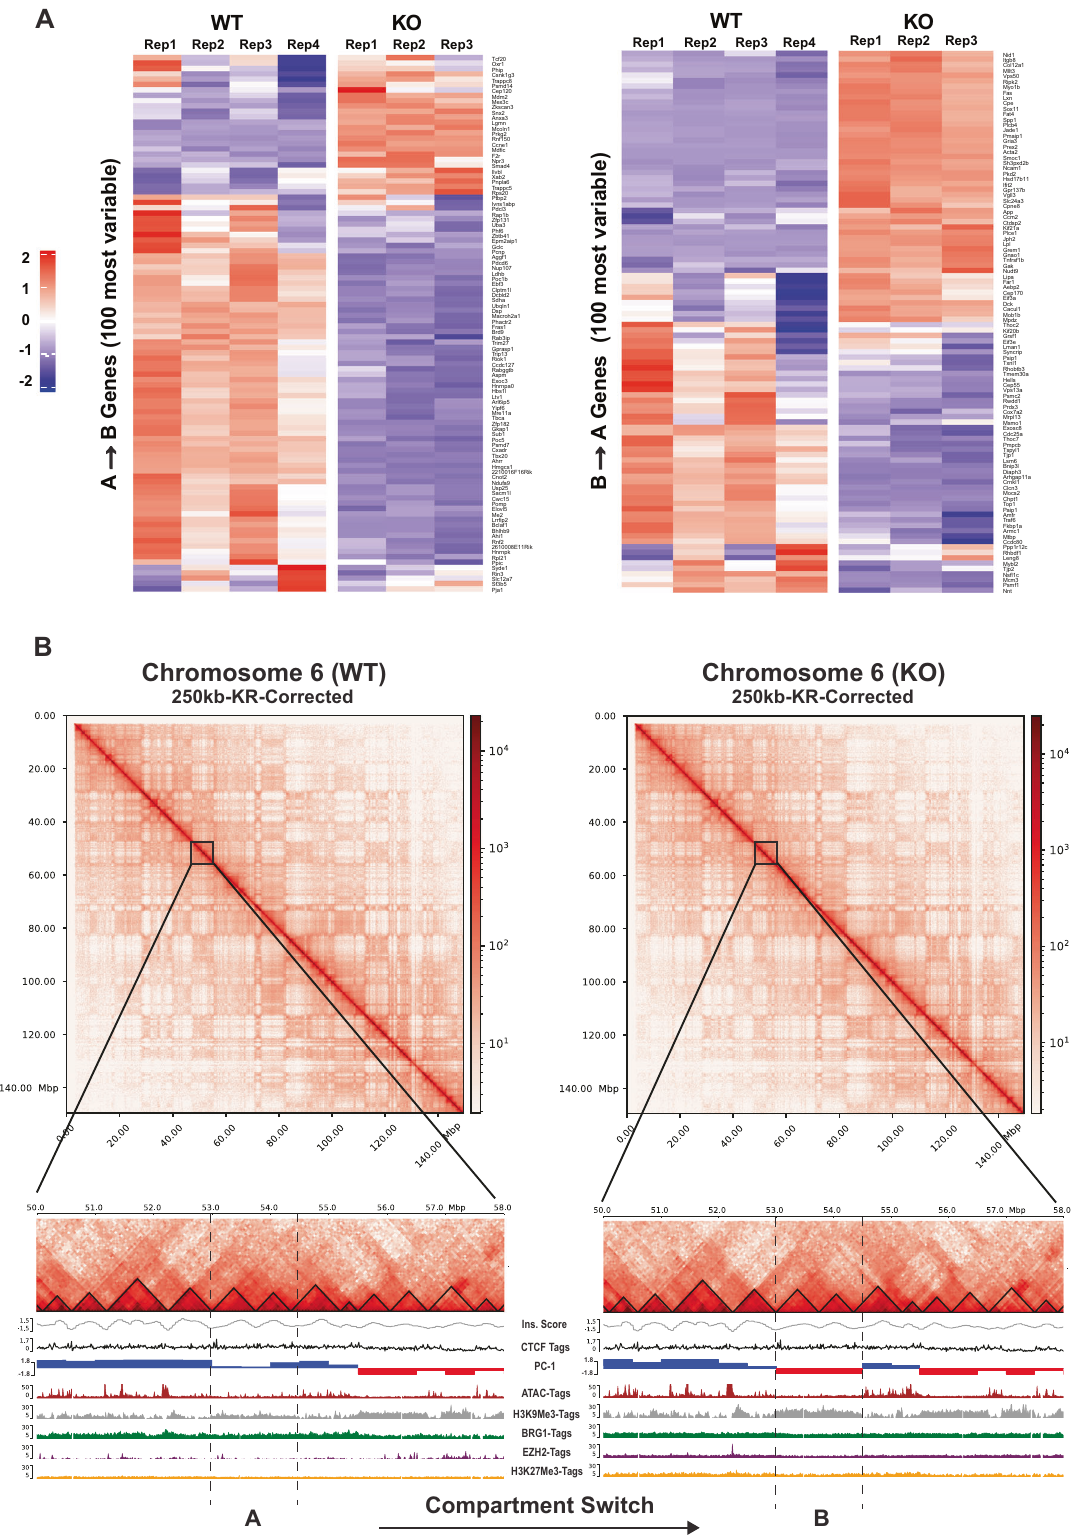
and B → A regions in the correlation of H3K9me3 and H3K27me3 with each other and with other epigenetic marks. H3K9me3 and H3K27me3 were much more highly correlated in A → B regions (Fig. 5A-iii, bottom right triangle) than in B → A regions (Fig. 5A-iii, bottom right triangle), potentially explaining why A → B regions are prone to repression. Our